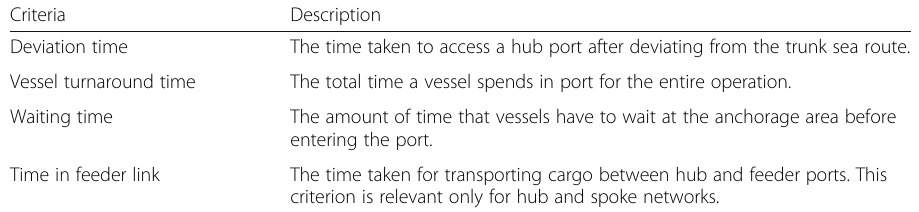
Table 3 Criteria Related to the Time Category